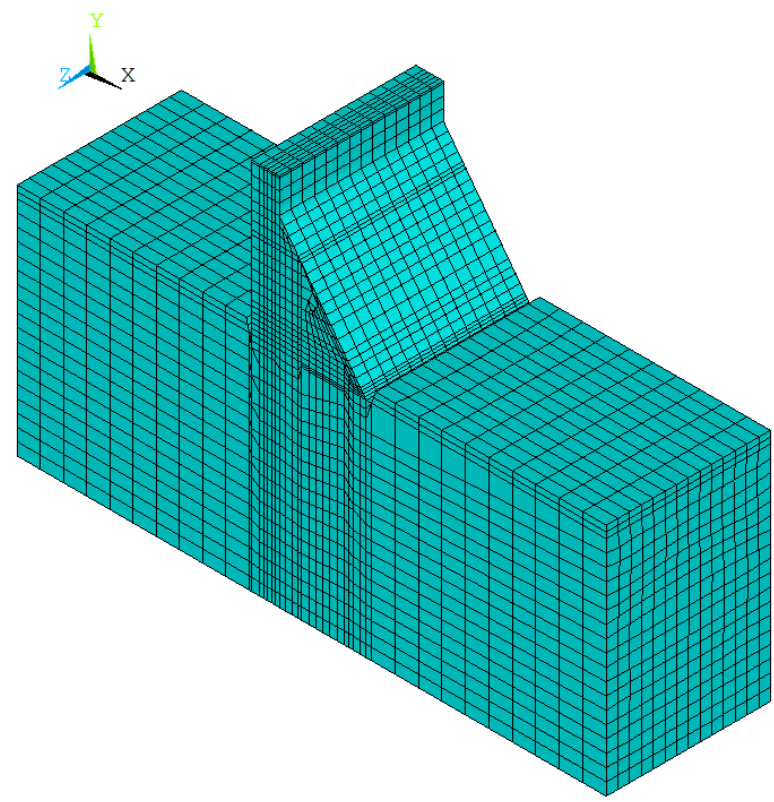
Figure 9. Overall finite element mesh of the dam in the macro scale.